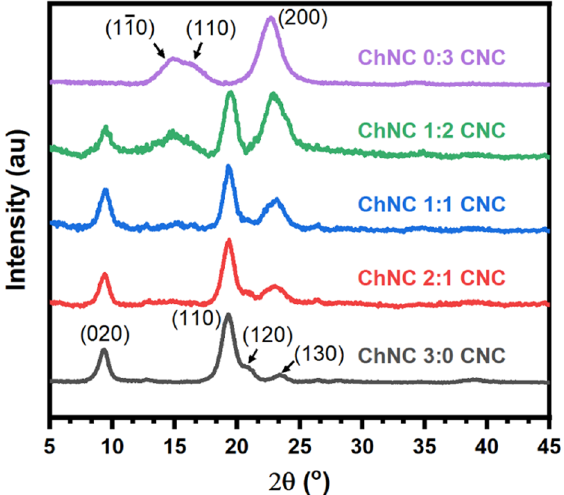
Figure 4. X-ray diffractograms of individual chitin (ChNC) and cellulose (CNC) nanoparticles along with ChNC-CNC nanoconjugates, showing a reduction in peak sizes as the concentration of nanoparticles is reduced.